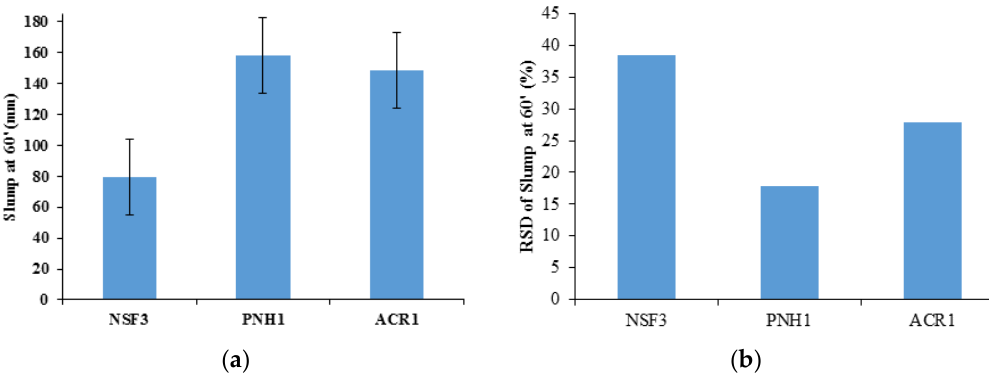
Figure 4. Slump mean value ( a ) and RSD ( b ) after 60 min since mixing procedure.